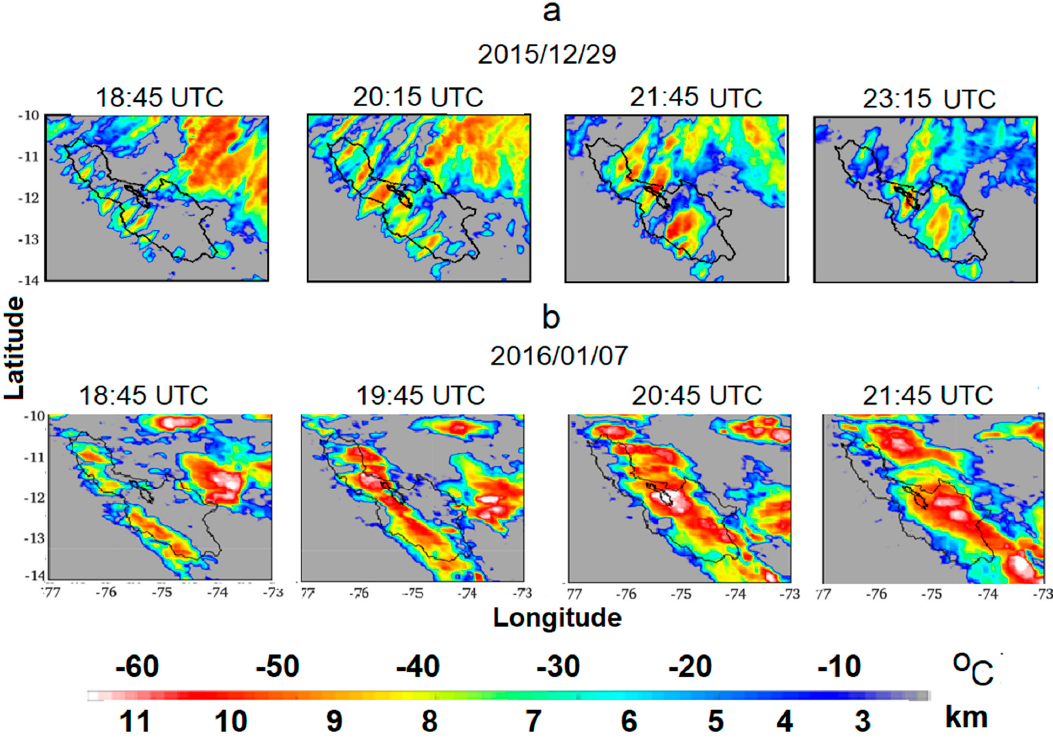
Figure 3. Images of the Geostationary Operational Environmental Satellites GOES infrared channel for the period of convective development in the area of the Mantaro river basin. The color bar indicates the brightness temperature and corresponding cloud top height. Time is indicated in the top titles of each panel. The contours of the basin and the valley are continuous black lines. ( a ) CRE1 ( b ) CRE2.